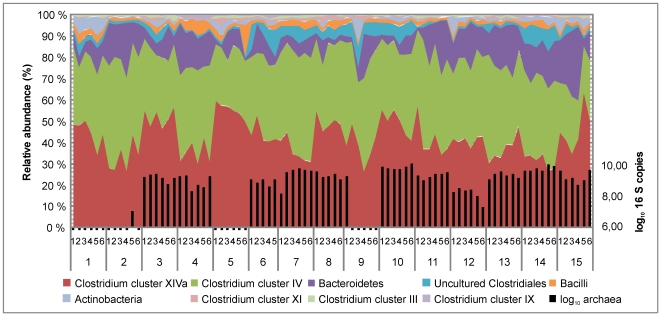
Microbiota composition of the study subjects.Relative abundance of the phylotypes that contributed over 0.5% to the total HITChip signal was summed up to phylum level, except Firmicutes, which were summed up to class or Clostridium cluster level (left y-axis). The qPCR-based quantification of the methanogens is shown on the right y-axis.